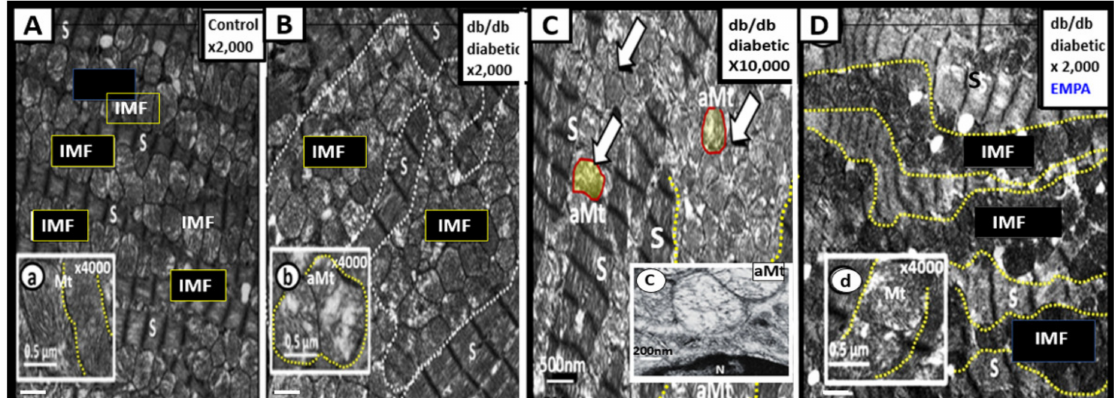
Figure 7. Mitochondria (Mt) biogenesis with impaired mitophagy in the 16-week-old obese, insulin- resistant, female diabetic db/db mice. Panel A illustrates a row of sarcomeres alternating with a row of intermyofibrillar (IMF) Mt in the lean non-diabetic control model. Panels B and C depict extensive Mt expansion due to Mt biogenesis with sarcomere disarray and accumulation of aberrant Mt (aMt) (open arrows and encircled yellow with red line). Note the presence of numerous hyperlucent aMt with loss of electron-dense Mt matrix and attenuation of crista as depicted in inserts ( b ) and ( c ) as compared to the control model in insert ( a ). These aMt are representative of impaired mitophagy, which allow aMt to accumulate. Additionally, these aMt are leaky and release increased superoxide– mtROS and cytochrome c, which in turn is associated with cardiomyocyte dysfunction and increased cardiomyocyte apoptosis. Panel D demonstrates an improved sarcomere (S) arrangement and note the marked improvement of electron-dense mitochondria in insert ( c ). Additionally, note the improvement of the Mt expansion and note that in insert ( d ) the Mt are more electron-dense and appear similar to control models in insert ( a ) in those models treated with empagliflozin (a sodium glucose transporter-2 inhibitor) for five weeks. These modified images were provided with permission by CC 4.0 [26]. Magnification × 2000 in panels A , B and D ; scale bar = 1 µ m and Magnification × 10,000; scale bar = 500 nm in panel C . Inserts = 0.5 µ m in panels ( a ), ( b ), ( d ); scale bars = 200 nm in insert ( c